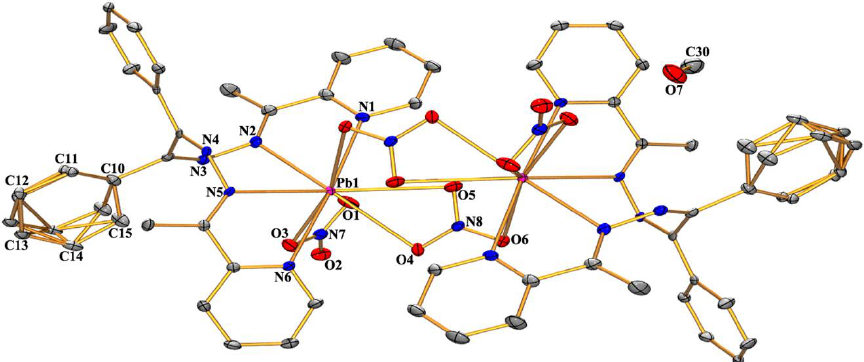
Figure 4. View of the asymmetric unit of compound ( 2 ) with partial atom numbering scheme. Hydrogen atoms are omitted for clarity. The unlabeled counterpart is generated through the symmetry operation. Thermal ellipsoids are drawn at the 30% probability level.